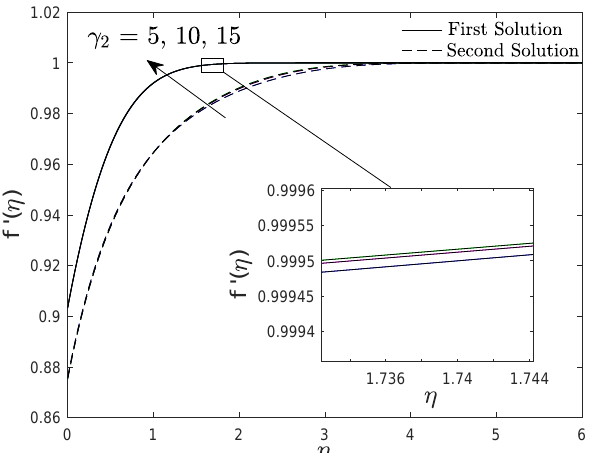
Figure 2. Nanofluid velocity along the x -direction for diverse values of γ 2 with λ = −